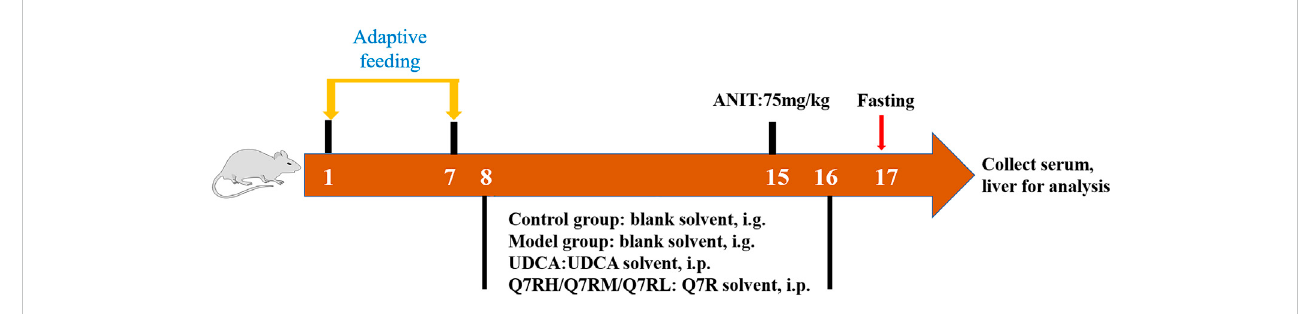
FIGURE 1 Diagrammatic sketch of the experimental design of the effect of Q7R on rat cholestatic hepatitis.